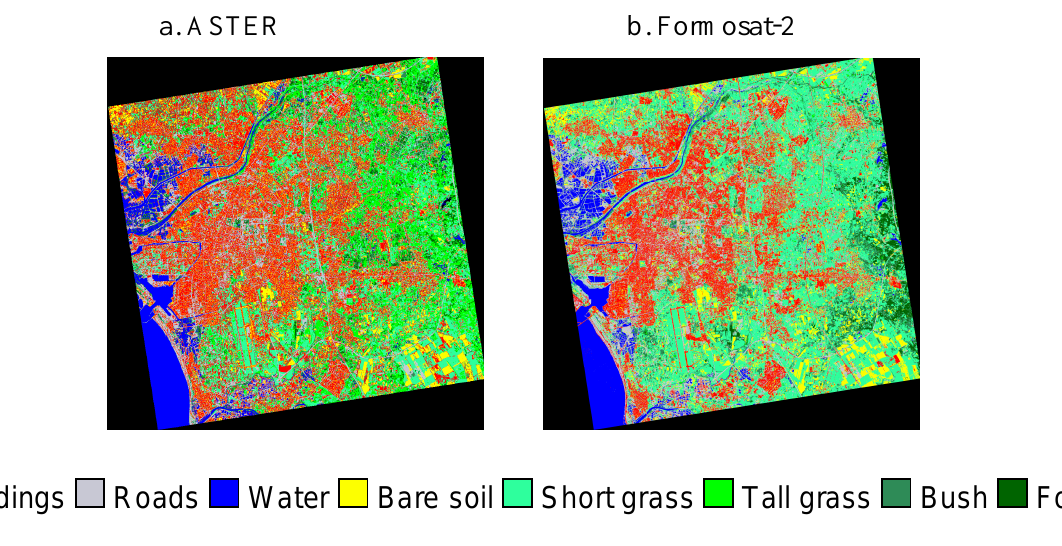
Figure 2. Surface classification maps derived from (a) ASTER and (b) Formosat-2 data. a. ASTER